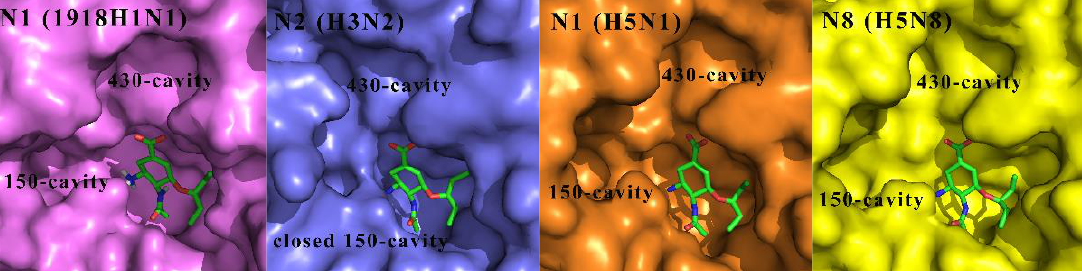
Figure 2. Comparison of the crystal structures of representative group-1 NAs N1 (1918H1N1, PDB ID: 3BEQ), N1 (H5N1, PDB ID: 2HU0), N8 (H5N8, PDB ID: 2HT7) and group-2 NAs N2 (H3N2, PDB code: 4GZP) used in our inhibition assay, bound to OSC (green).